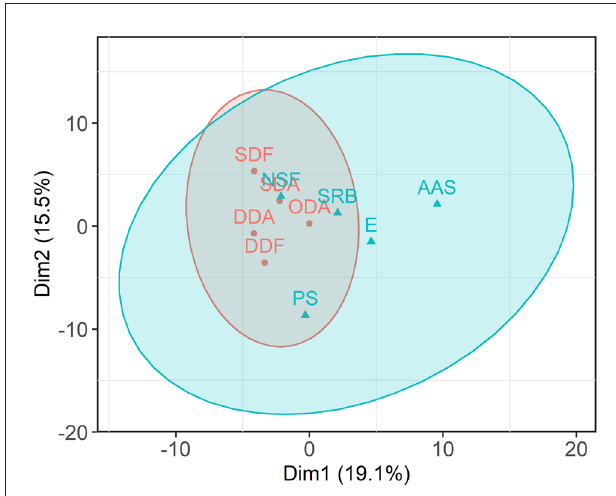
FIGURE2 Cleaned cluster analysis showed clustering of Canine Behavioral Assessment and Research Questionnaire (C-BARQ) factors reflecting social fear and aggression (dog-directed fear [DDF], dog-directed aggression [DDA], stranger-directed fear [SDF], stranger-directed aggression [SDA], owner-directed aggression [ODA]) and another clustering of mixed factors (excitability [E], attachment or attention-seeking [AAS], separation-related behavior [SRB], nonsocial fear [NSF], pain sensitivity [PS]), when non correlating C-BARQ factors (chasing, trainability) were previously excluded, indicating a low discriminatory power of fear and